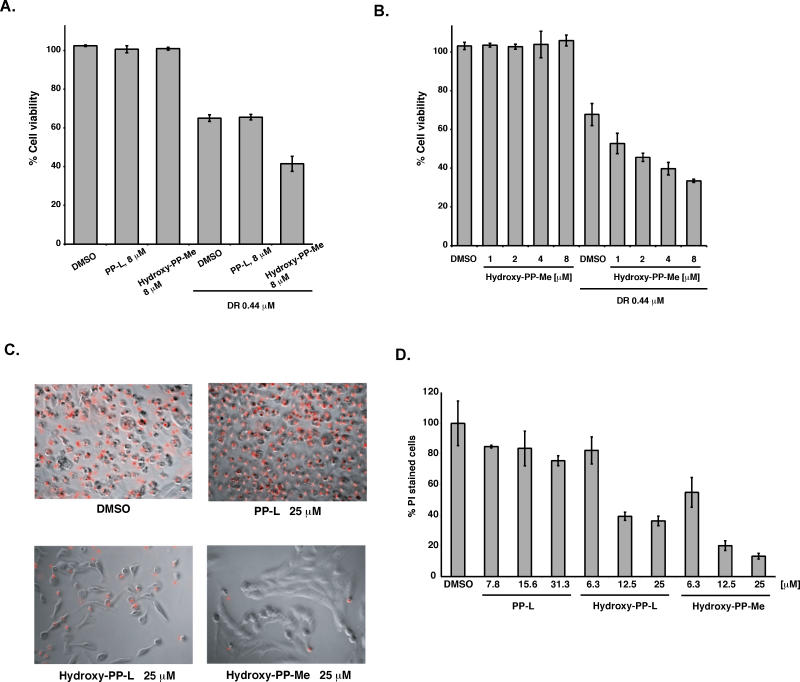
CBR1 Inhibitors Enhance Daunorubicin-Mediated A549-Cell Killing, yet Prevent Apoptosis in Serum-Starved Cells(A) Cell viability as a function of drug treatment. DMSO, PP-L (8 μM), and hydroxy-PP-Me (8 μM) do not have a pronounced effect on cell viability when used alone. Daunorubicin (DR) alone induces a moderate decrease in cell viability that is accentuated by concomitant treatment with hydroxy-PP-Me.(B) Cell viability decreases dose dependently with concomitant daunorubicin (DR) treatment. Daunorubicin treatment induces a moderate decrease in cell viability when used alone. Hydroxy-PP-Me (1–8 μM) induces a dose-dependent decrease in cell viability with concomitant daunorubicin treatment.(C) PI staining of dead cells is appreciably decreased in serum-starved cells treated with CBR1 inhibitors. A high number of cells were PI stained 65 h following serum starvation in both control and PP-L treated conditions (top). Cells treated with the CBR1 inhibitors hydroxy-PP-L or hydroxy-PP-Me during serum starvation show appreciably less staining (bottom).(D) Quantification of PI-stained cells by fluorescence measurement 65 h following serum starvation. Hydroxy-PP-L and hydroxy-PP-Me induce a dose-dependent decrease in PI staining; whereas PP-L does not.